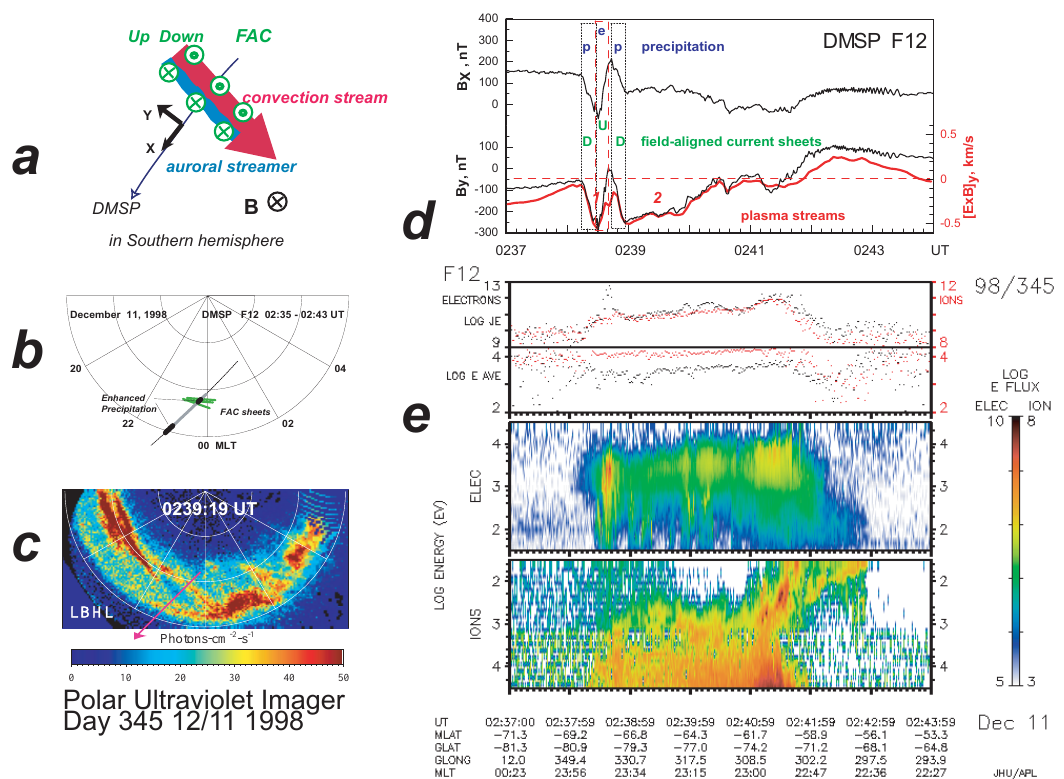
Fig. 1. Scheme of spacecraft crossing in the Southern Hemisphere through the auroral streamer, convection jet and associated field-aligned current sheets (a) and a summary of DMSP F12 observations for the crossing of the auroral streamer at 02:38 UT, including: (b) DMSP trajectory in the Southern Hemisphere with hatched regions of strong precipitation and positions/orientations of the planar FAC sheets (shown by green lines); (c) Polar UVI images in the Northern Hemisphere, the pink arrow shows approximately the mapped DMSP trajectory; (d) summary of transverse magnetic variations and convection flow measured by DMSP F12; (e) traces of proton and electron energy fluxes and average energies together with electron and proton